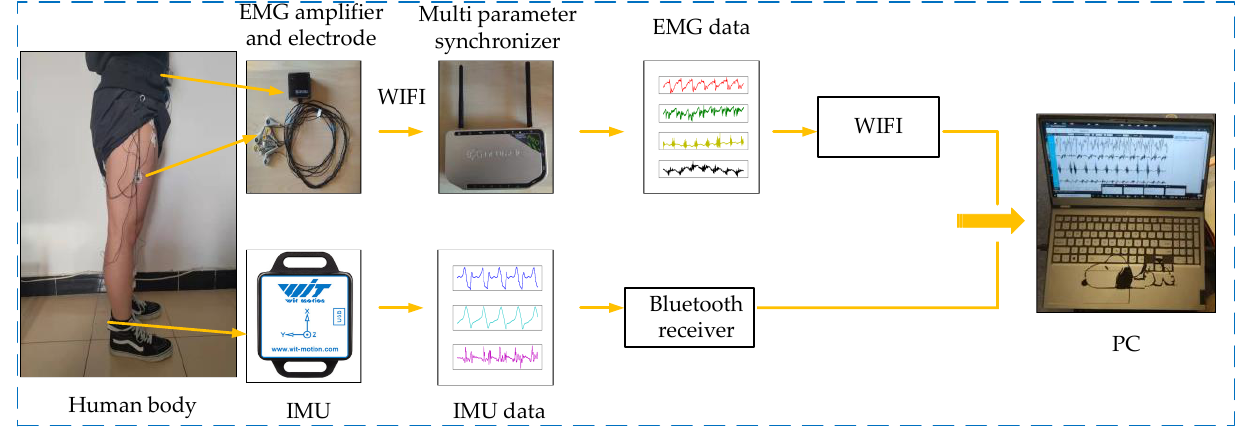
Figure 1. Wearable bioelectronics device of human lower limb movement information fusion.